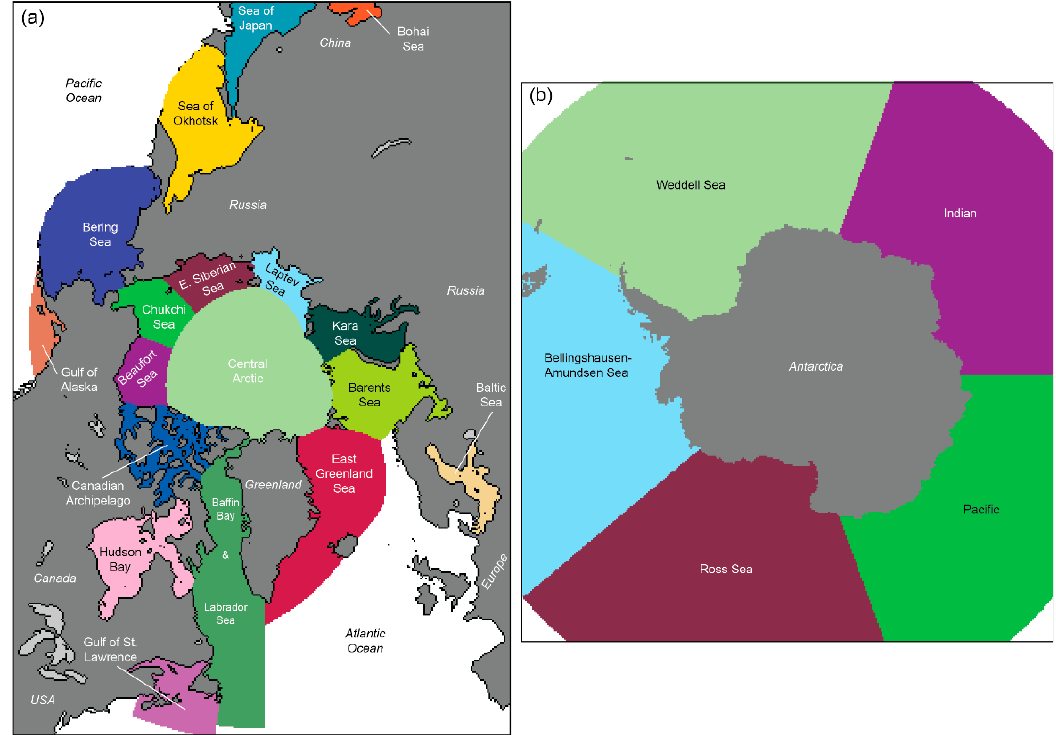
Figure 5. Map of ( a ) Northern Hemisphere and ( b ) Southern Hemisphere regions.